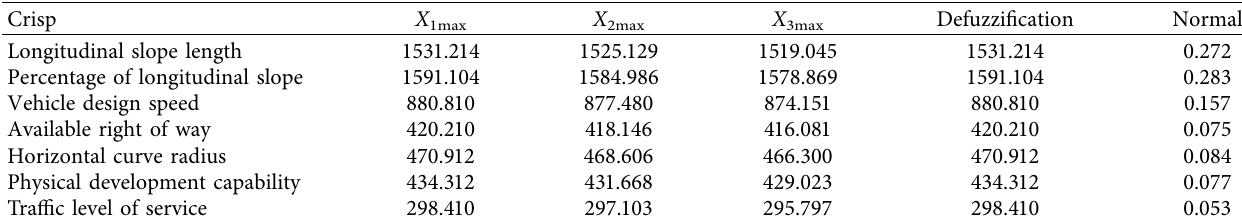
Table 6: Defuzzification and determination of the definite weight of technical